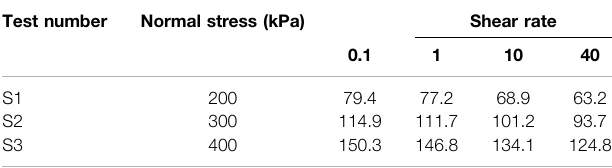
TABLE 2 | Residual strength of sliding zone soils with different shear rates. Test number Normal stress (kPa)